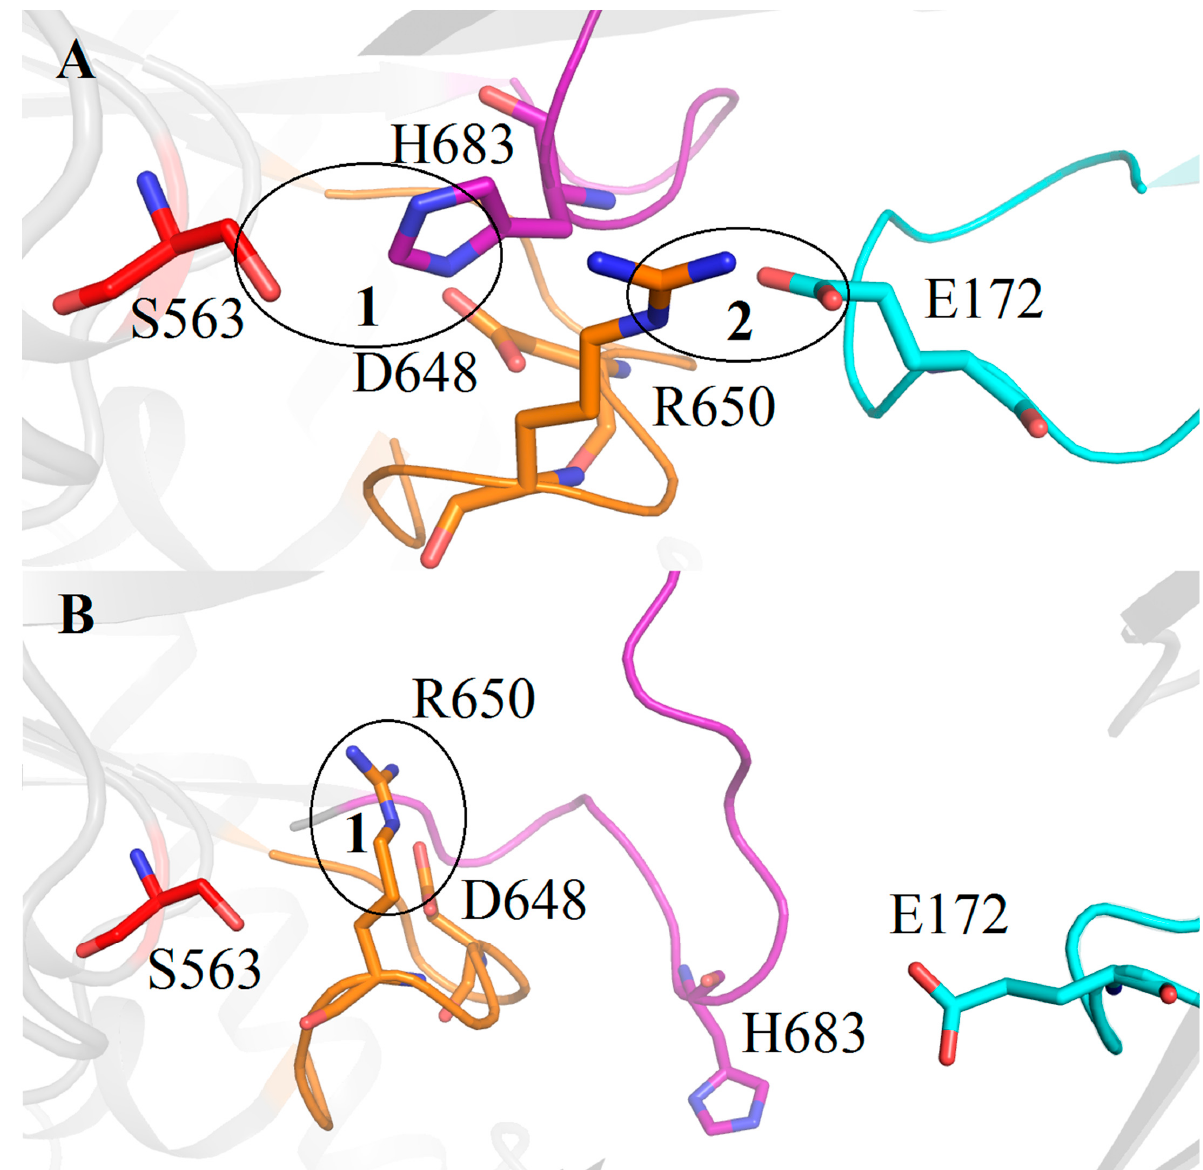
Figure 6. Cartoon/ribbon presentation of the assembled and dissembled catalytic triad in the closed ( A ) and open ( B ) state of TbOpB, respectively. Catalytic residues S563, H683, and D648 are colored in red, magenta, and gold, respectively. The covalently bound inhibitor is omitted. H- and D-loops are in the same color as the respective catalytic residues. The β -propeller loop carrying the E172 residue, which forms the interdomain SB1 with R650 and stabilizes the catalytic triad in the closed conformation, is colored in cyan. The interactions described in the text are encircled and enumer- ated.